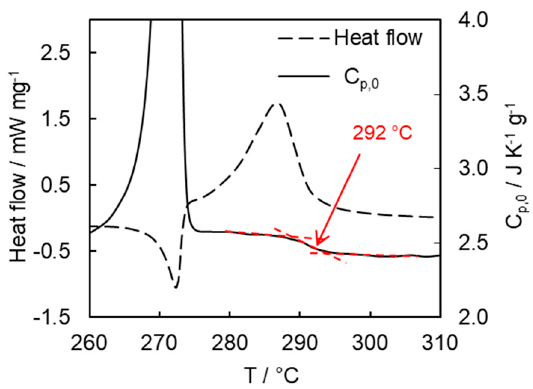
Figure 5. Non-reversing heat flow and quasistatic heat capacity curves for cyanate ester polymerization measured at 1 °C min − 1 by stochastically modulated DSC (arrow denotes the midpoint temperature of vitrification).